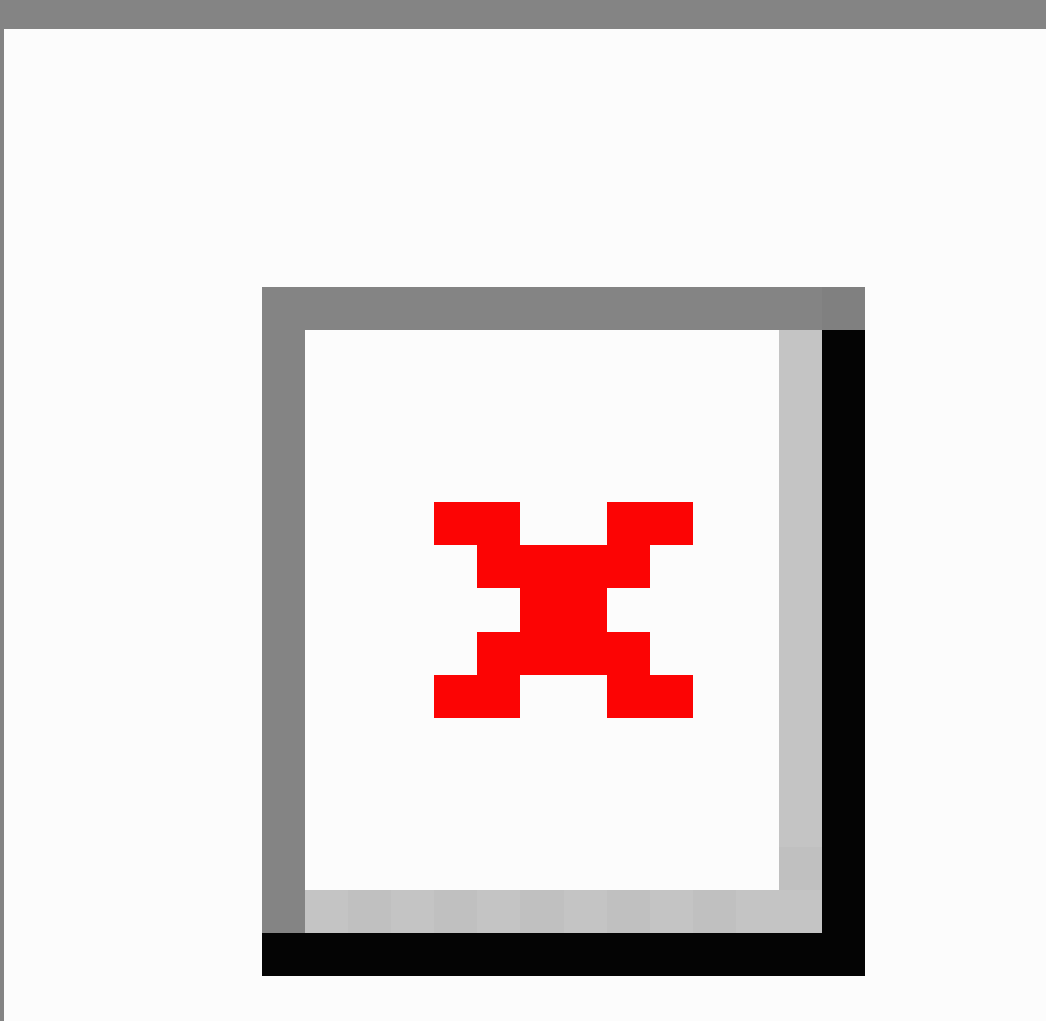
Figure 3. Evolution of average time in under- and over-anticoagulation (International Normalized Ratio [INR] <1.5 and INR>5, respectively) in the 3 visits of the follow-up period. The two oral anticoagulant therapy (OAT) management groups (conventional control and telecontrol with SintromacWeb system) are